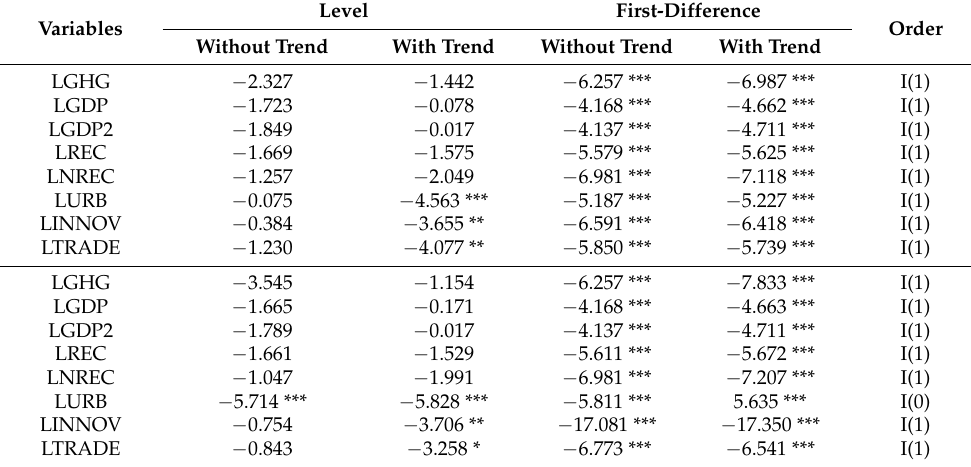
Table 3. Results of Unit Root